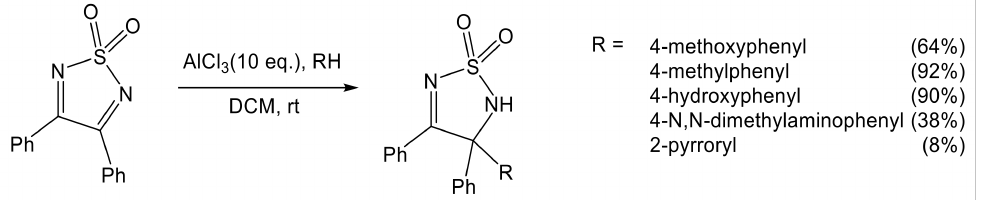
Figure 8. AlCl 3 catalyzed addition of phenols to the C=N double bond of 3,4-diphenyl 1,2,5- thiadiazole 1,1-dioxide